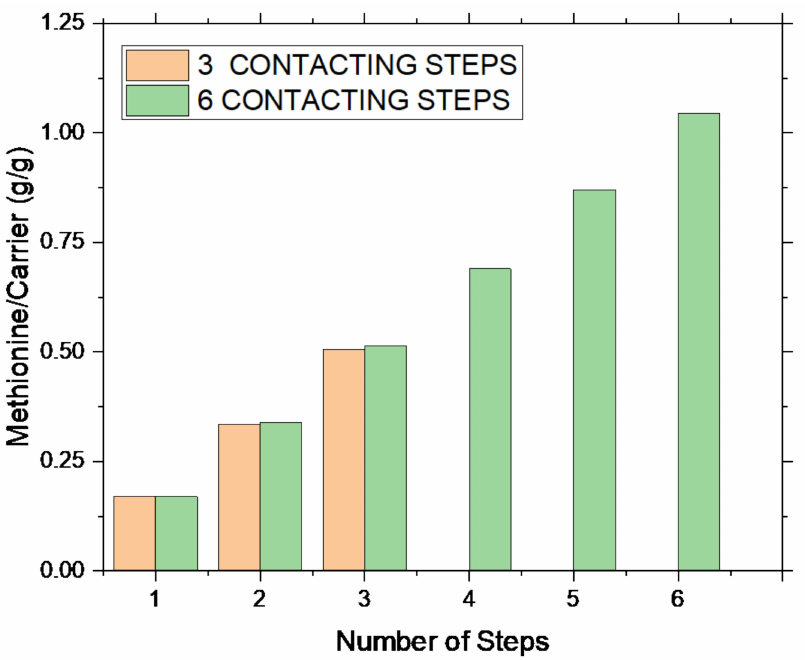
Figure 5. Methionine capture as a function of repeated three or six intercalation steps for the system